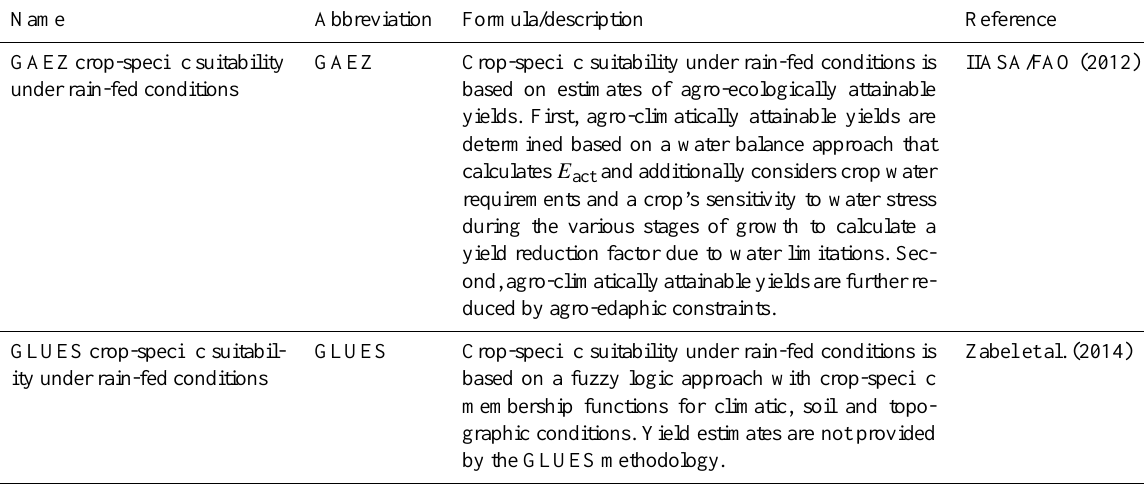
Table A4. Agricultural suitability under rain-fed